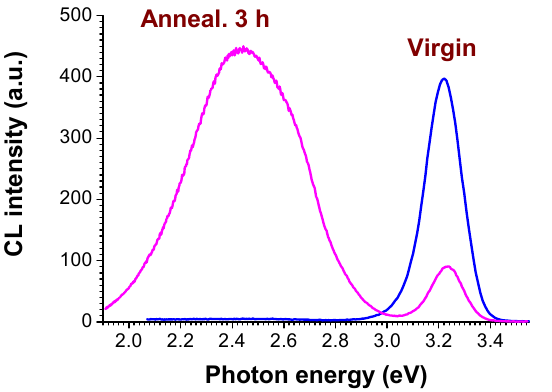
Figure 9. CL spectra measured at room temperature on the virgin and annealed at 550 ◦ C for 3 h nanorod arrays.